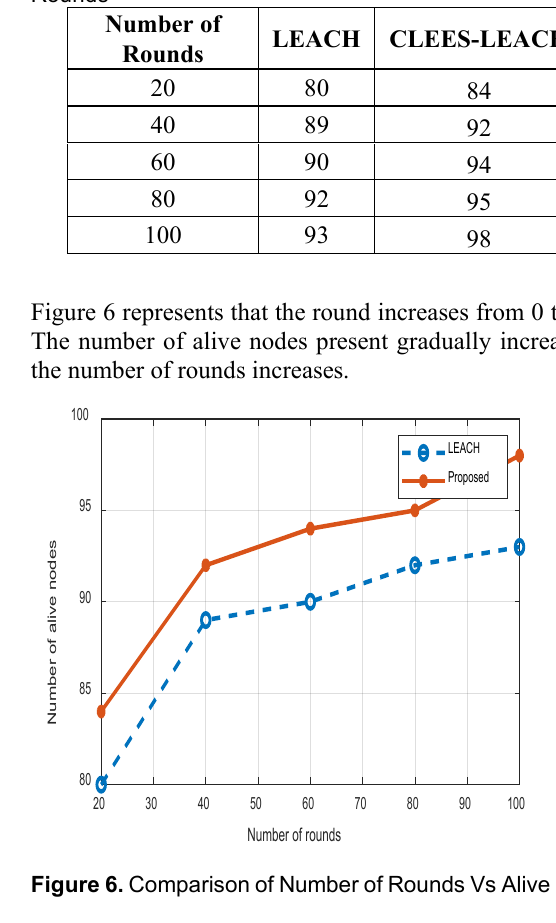
Table 4. Comparison of Alive Nodes Present for Various